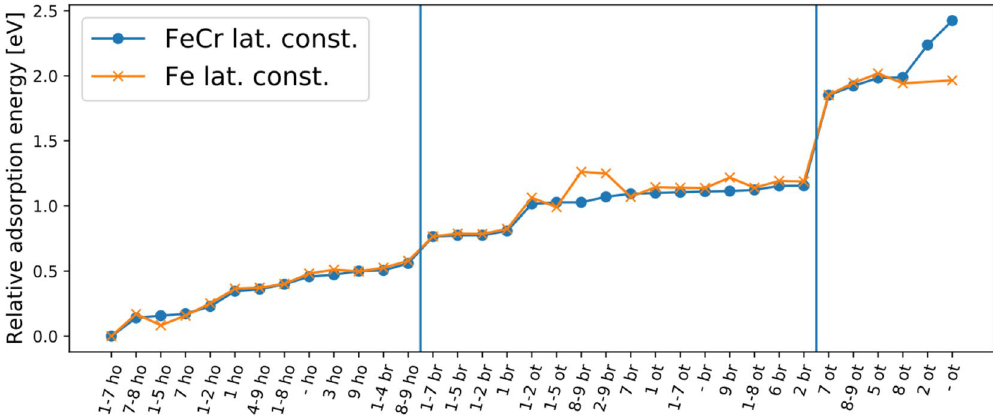
Figure 3. Relative adsorption energies of oxygen in the Fe and Fe 0.91 Cr 0.09 systems (the energy of the ‘1–7 ho’ case is shifted to 0 eV for both systems, with E ad = − 4.37 eV and − 4.35 eV for the Fe and Fe 0.91 Cr 0.09 ‘1–7 ho’ cases, respectively). The difference between the two systems is minimal except for a few cases. The sites have the following labels: ‘br’ is a bridge site, ‘ot’ is an on-top site and ‘ho’ is a hollow site. The numbers in front indicate the position(s) and number of Cr atoms in the surface: one number indicates one Cr atom, and two numbers separated by a hyphen indicate two Cr atoms in the surface; a hyphen without any numbers indicates a pure Fe surface. The atomic sites are numbered as in Fig. 1. The left (right) vertical line separates all the hollow (bridge) adsorption cases to its left. From the point of view of energetic stability (see Supplementary Information), the most relevant configurations are those that have Cr only in the surface layer, i.e. at sites from 1 to